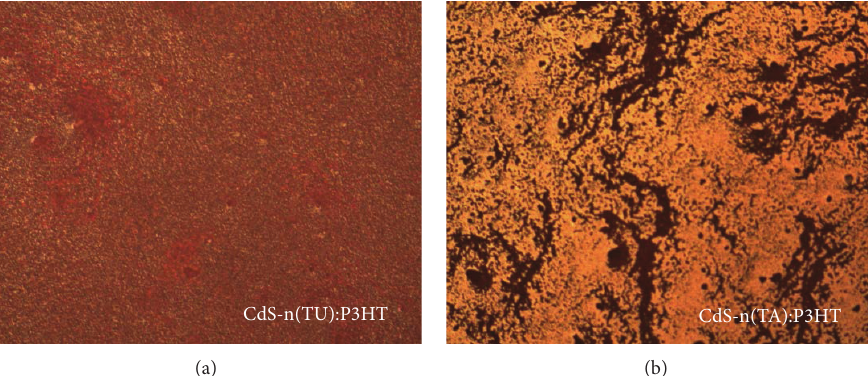
Figure 5: Optical micrographs of CdS-n:P3HT bulk or composite layers with CdS-n:P3HT mass ratio of 6 :1. The CdS-n products in the layers were (a) CdS-n(TU) and (b) CdS-n(TA). ), photovoltage at open circuit ( 𝑉 ), fill factor (FF), and conversion efficiency ( 𝜂 ) Table 3: Photocurrent density at short circuit ( 𝐽 sc oc of hybrid solar cells with CdS-n(TU) with diffused structure: ITO/CdS-f/CdS-n(TU)/P3HT/CP/Au, bulk structure: ITO/CdS-f/CdS- n(TU):P3HT/CP/Au, and reference cell: ITO/CdS-f/P3HT/CP/Au. Solar cell for